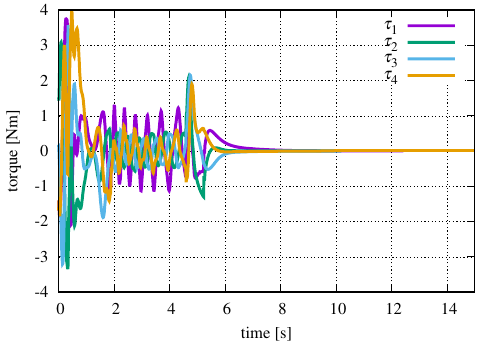
Figure 16. Case 2: Time variation of the input torque.